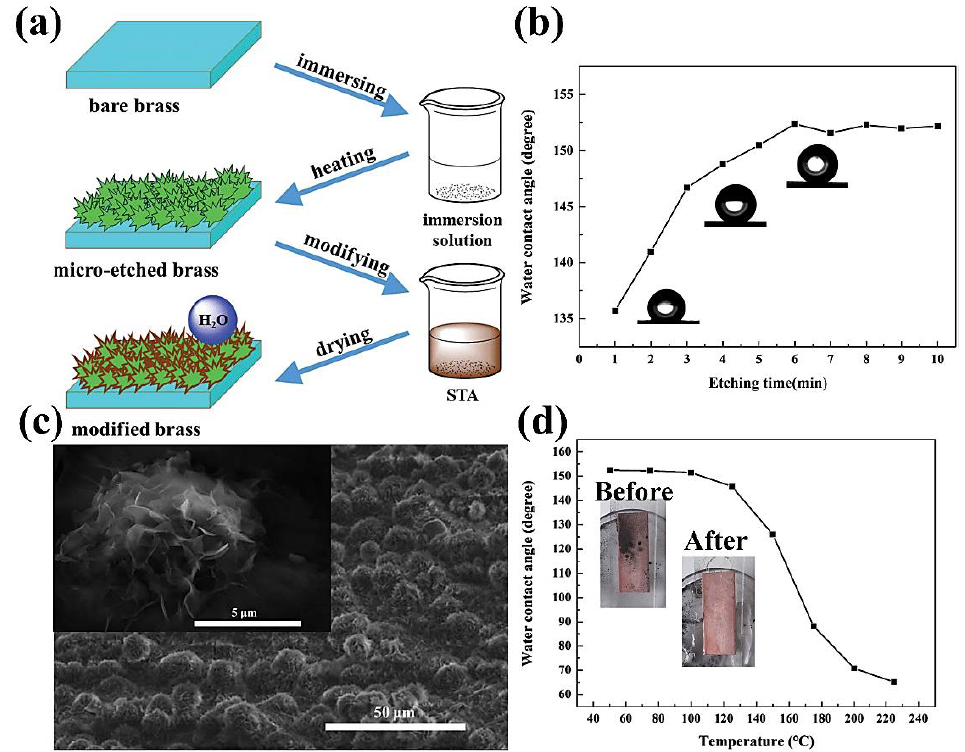
Figure 11. ( a ) Schematic illustration of the process of fabrication of a superhydrophobic surface on the brass substrate; ( b ) Effects of the micro-etching time on contact angle of the as-prepared surface; ( c )